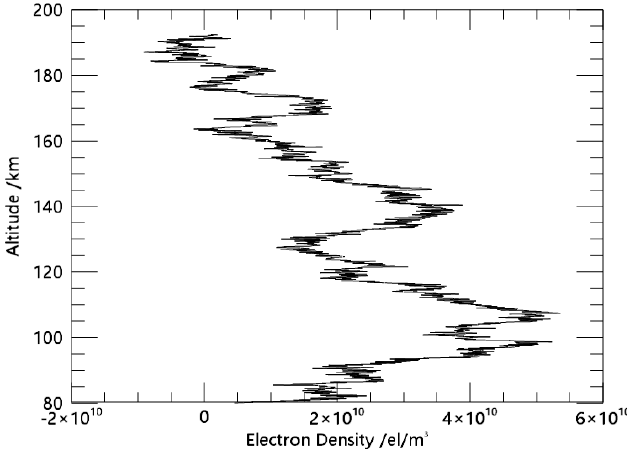
Figure 4. Retrieved Mars ionosphere electron-density profile.